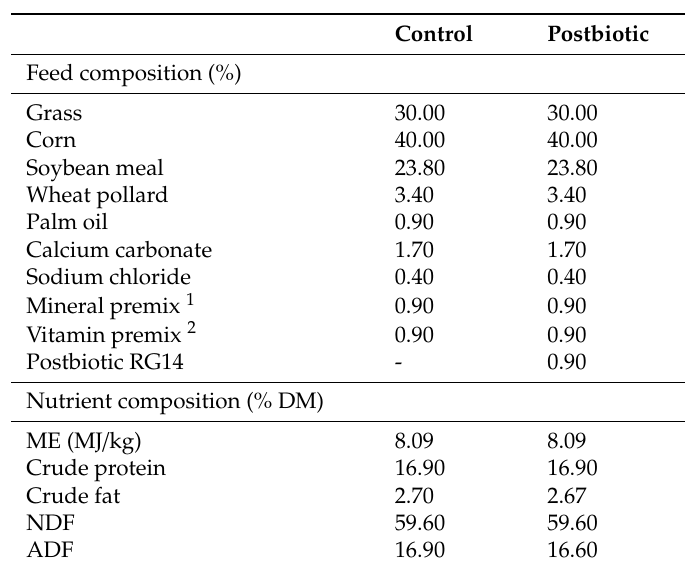
Table 1. Feed and nutrient